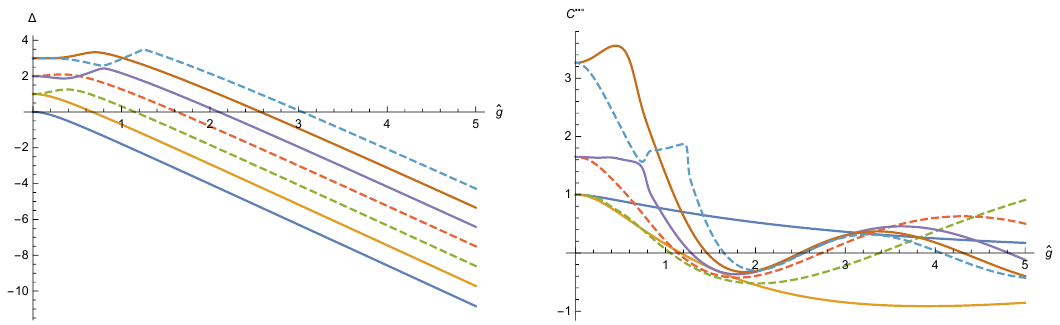
Figure 2 . The spectrum (left) and the diagonal Heavy-Heavy-Light correlator given by (1.3) (right) for the (cid:12)rst several states ( n = 0 ; 1 ; : : : ; 7), with all angles equal to (cid:30) = 1. The solid blue line corresponds to the usual cusp, while others correspond to excited states with scalar insertions discussed in section